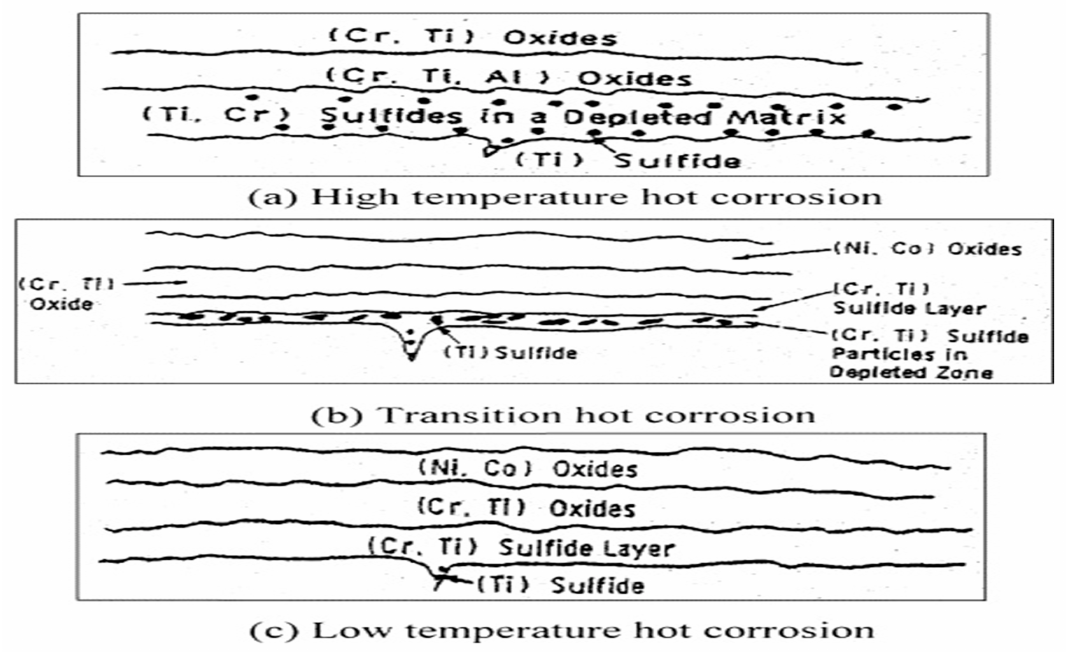
Figure 2. Hot corrosion mechanism in a gas turbine blade. Reprinted with permission from [42]. 2004, M.R Khajavi, M. H Shariat.